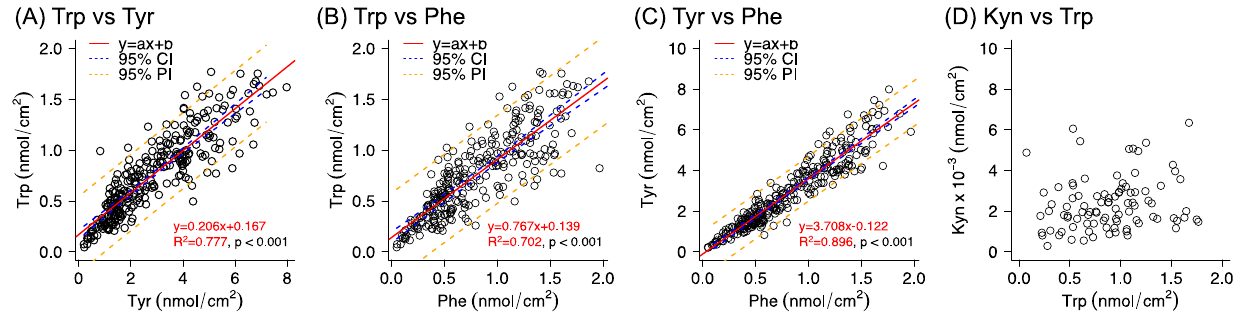
sampling sites. The plots include regression line, the 95% confidence interval (95% CI), and the prediction interval (95% PI). In case of Kyn vs. Trp ( D ), the R 2 was 0.033 and p = 0.080. Number of data points: n = 277 for Tyr, n = 274 for Phe, n = 277 for Trp, and n = 93 for Kyn.